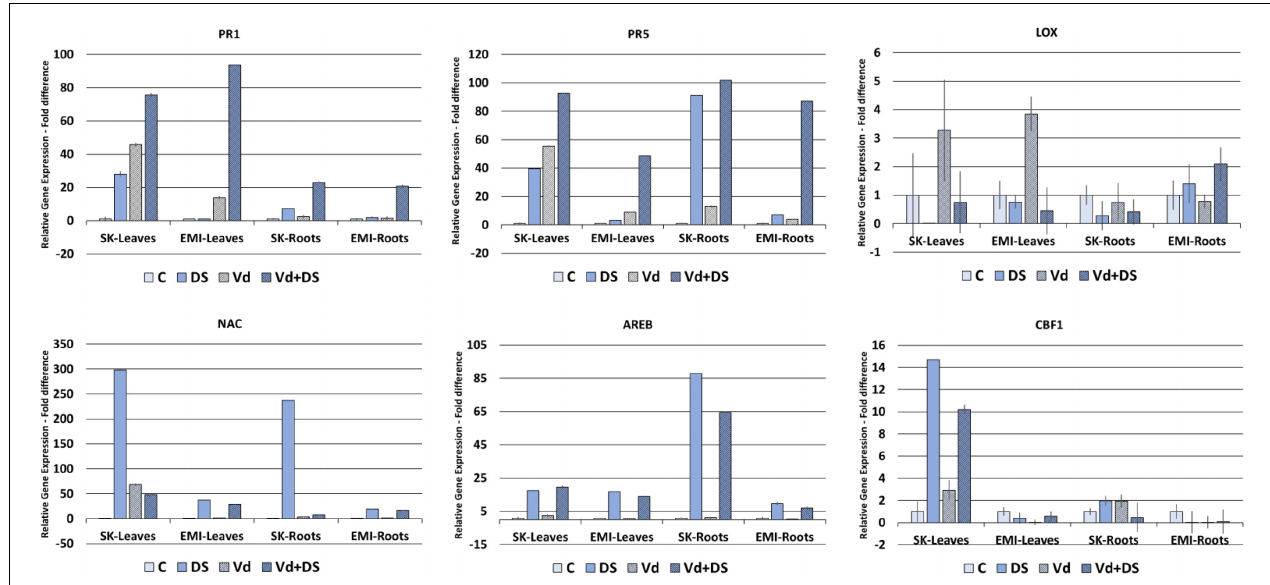
FIGURE 4 | Relative gene expression of the PR 1, PR 5, LOX , NAC , AREB , and CBF 1 marker genes in leaves and roots of eggplant plants subjected to abiotic, biotic, and combined stresses. The relative expression of selected marker genes was measured in eggplant cultivars under individual and combined stress. C, control; DS, drought stress; Vd, Verticillium dahliae ; Vd+DS, Combined stress. Bars represent standard